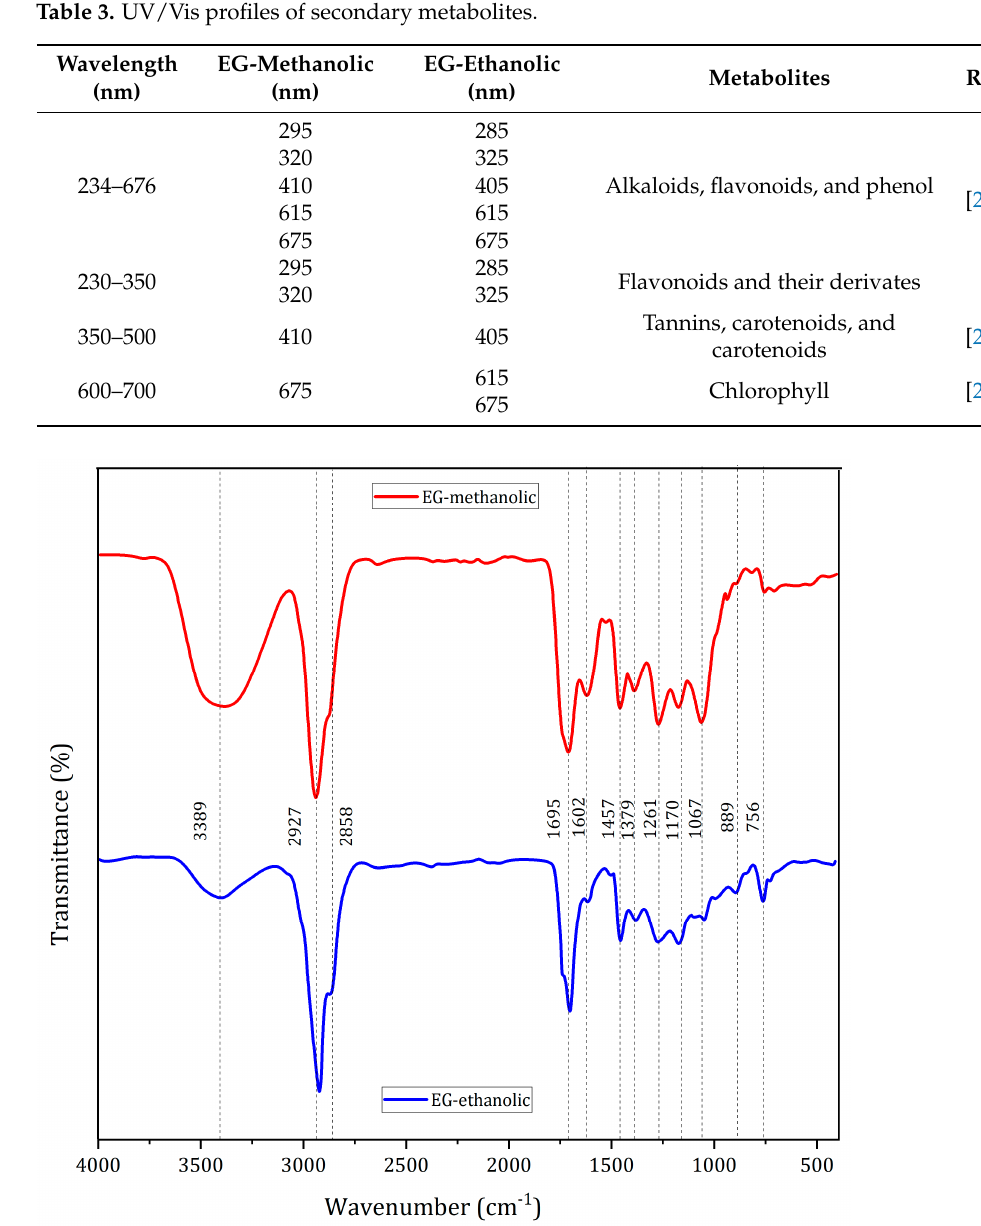
Figure 3. FTIR pattern of Eupatorium glutinosum Lam. plant extract